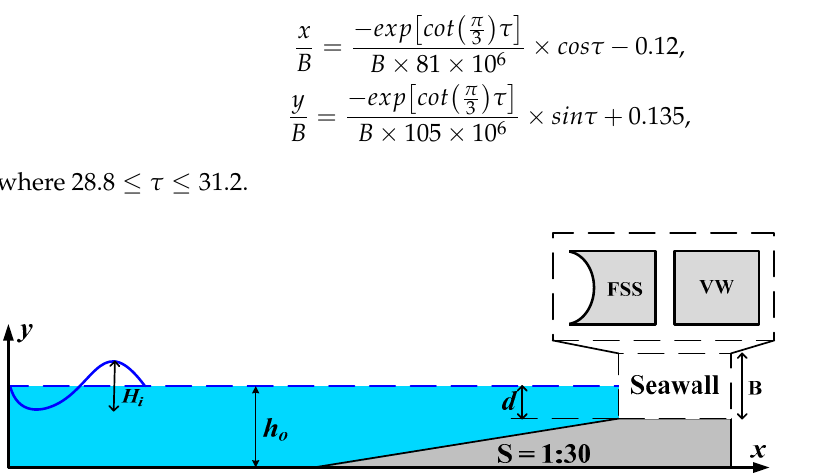
Figure 3. Sketch of the experimental setup of a cnoidal wave propagating toward the seawall ( h o = 1.0 m, d = 0.54 m, B = 0.81 m).